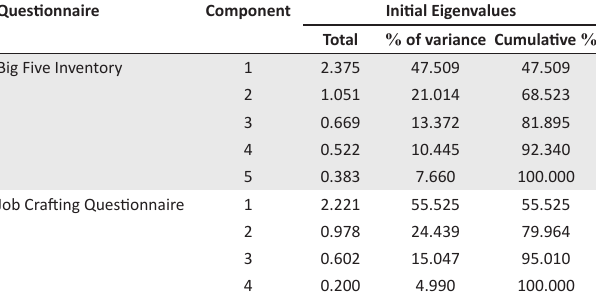
TABLE 2: Initial eigenvalues for the total variances